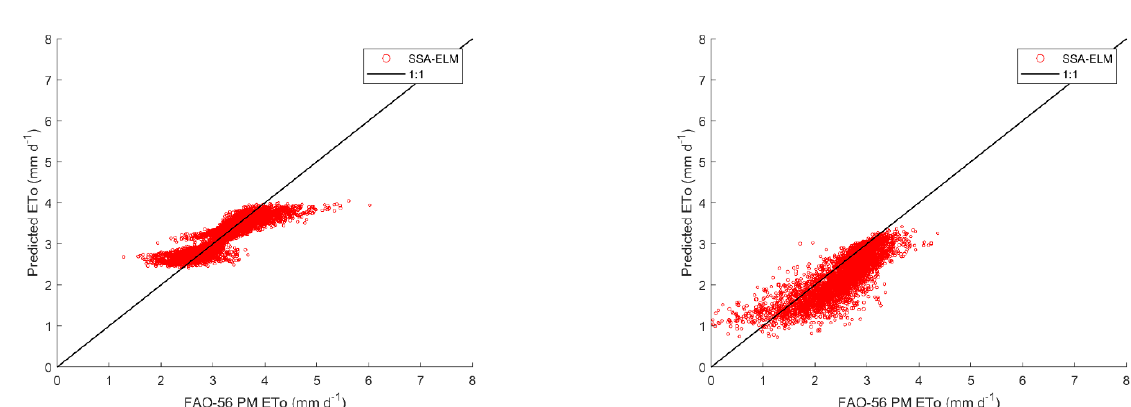
51477 − 0.981 52866 − 0.948